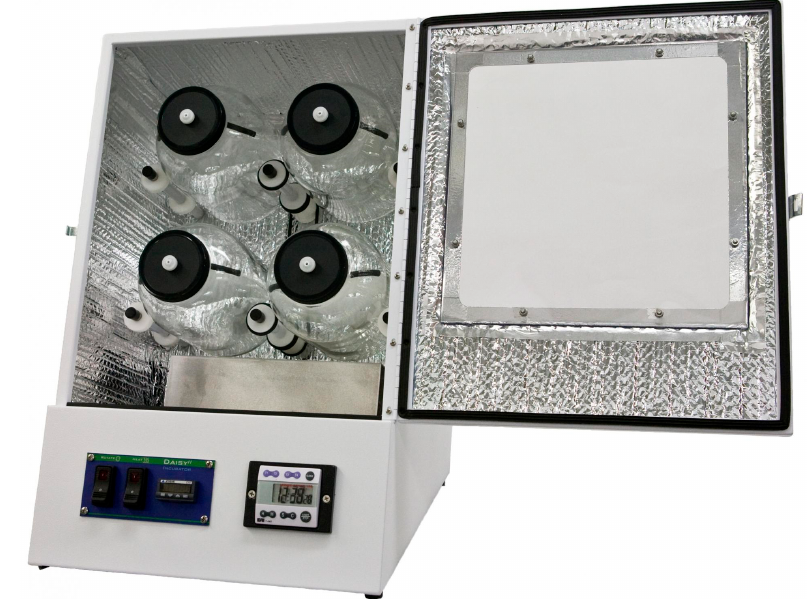
Figure 1. The Daisy II incubator (Ankom Technology Corporation Fairport, New York, NY, USA).